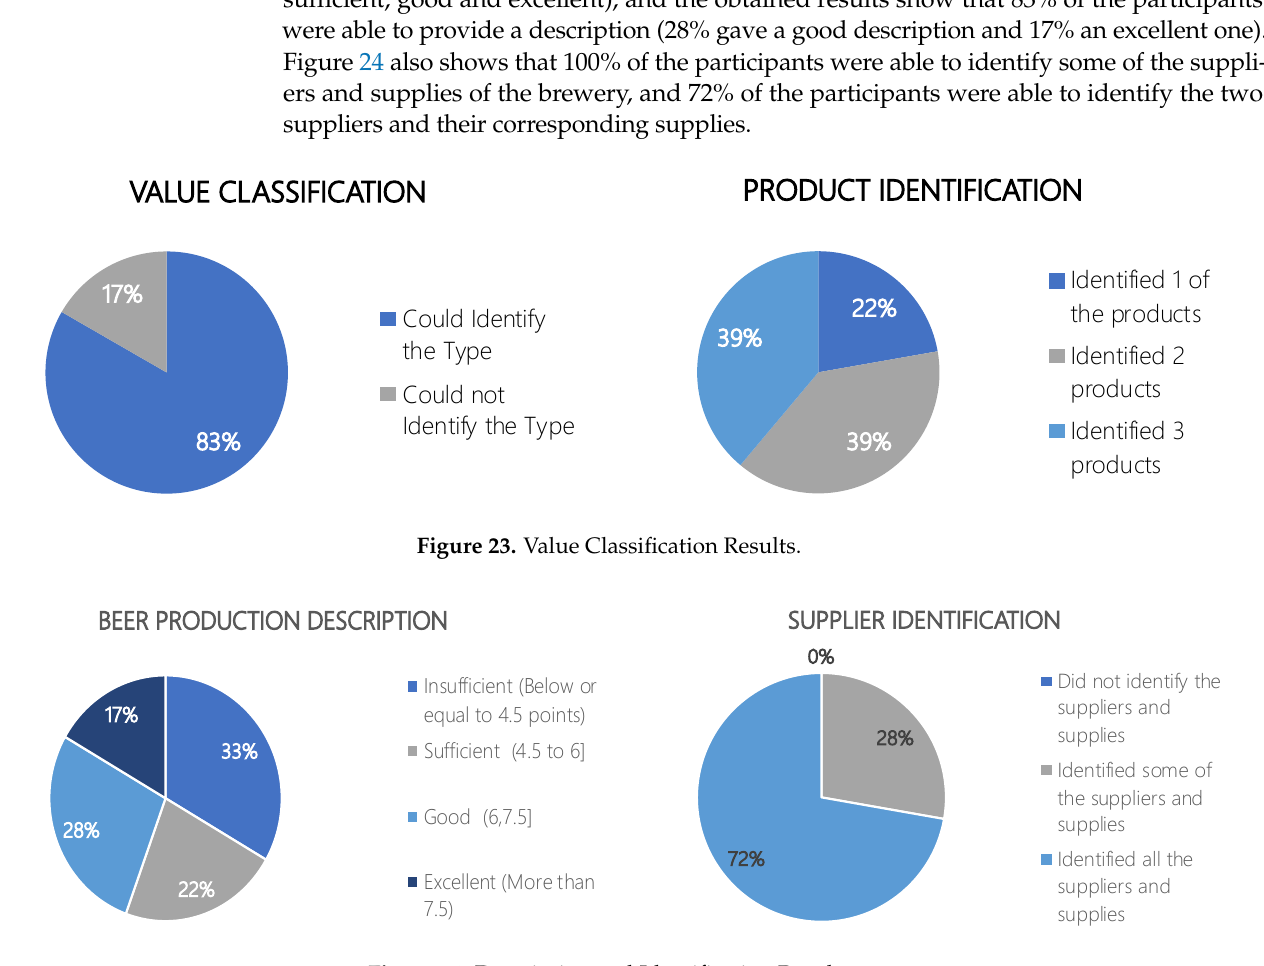
Figure 24. Description and Identification